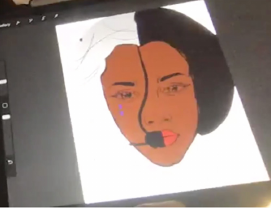
Image Perceptual dimension Structural dimension